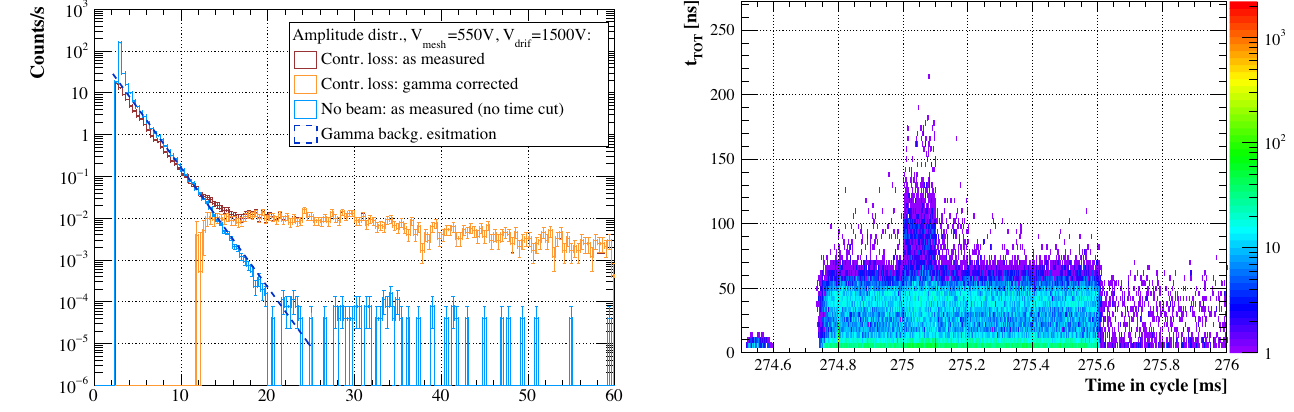
FIG. 13. Amplitude distributions extracted during the con- trolled loss experiment (red) and during an overnight data acquisition where beam was not present (blue). The distributions are normalized to give counts/s in each amplitude bin. Dark blue dashed line indicates estimated contribution of the γ part. Orange histogram represents the red distribution with γ correction applied.